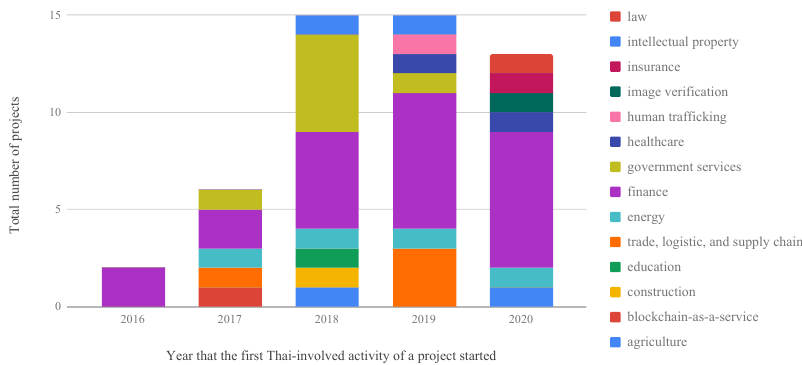
Figure 13. A trend of blockchain domain from